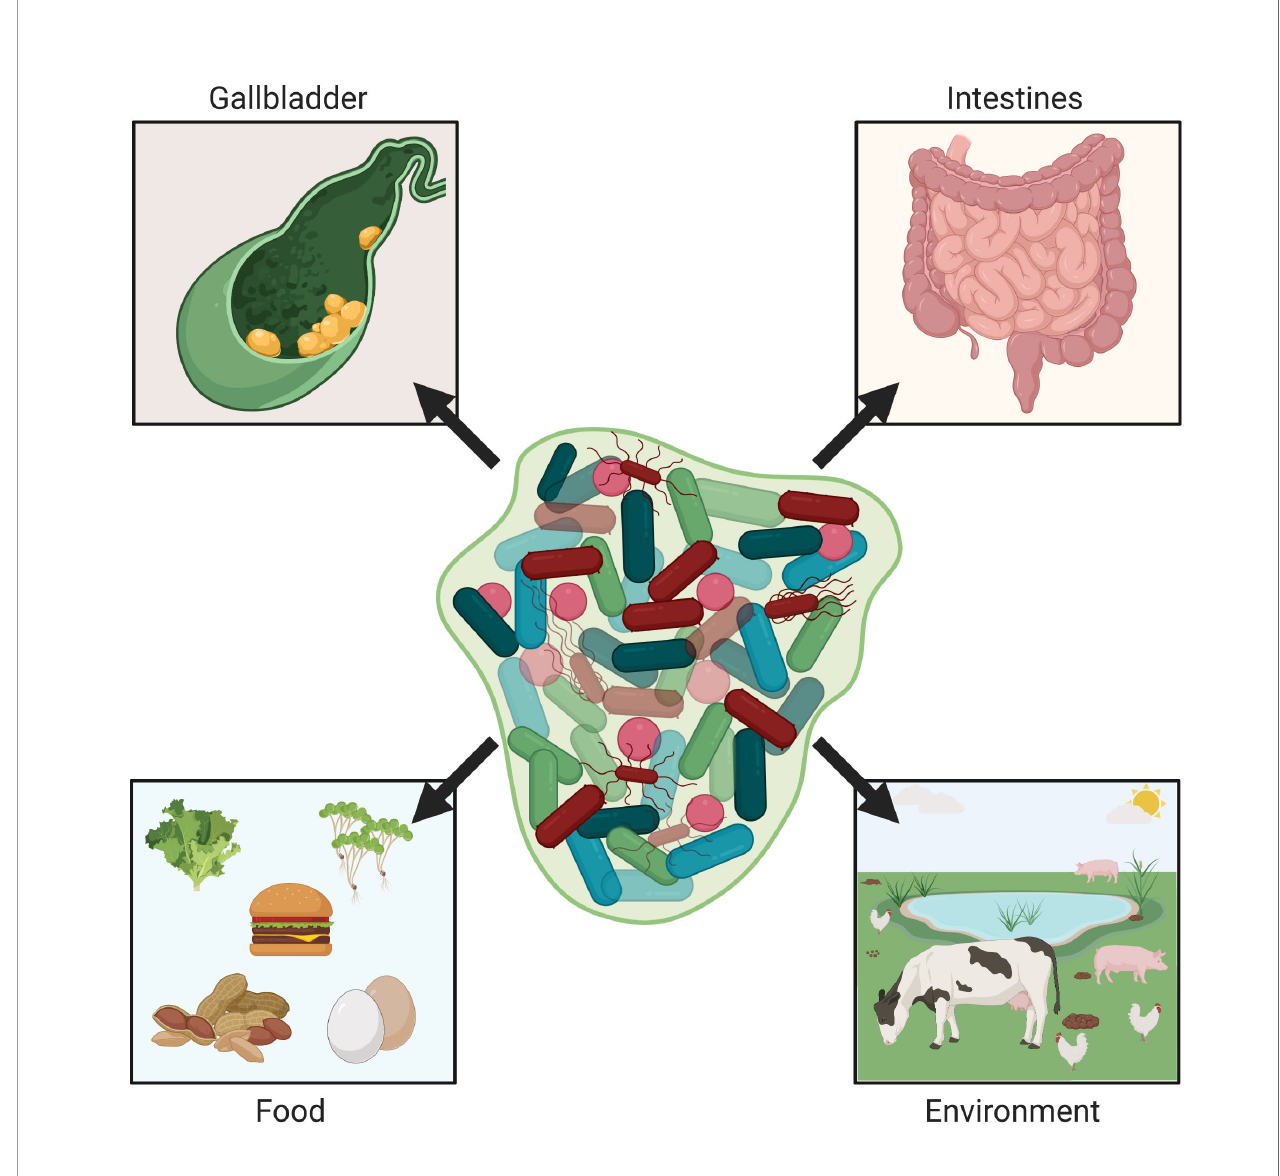
FIGURE 1 | Salmonella bio fi lms in the environment and humans. Non-typhoidal and typhoidal salmonellae are naturally acquired by humans through environmental or food sources. Salmonella Typhimurium colonizes and can form bio fi lms on various types of produce, while S . Enteritidis is often found within and on eggs. When within the intestines of various non-human animal species, salmonellae can cause either diarrheal disease or be a non-pathogenic inhabitant (e.g., in the chicken). This can lead to contaminated meat upon animal processing or shedding resulting in contaminated animal feces. Once ingested by the host, Salmonella spp. are capable of forming bio fi lms in the intestines and for S . Typhi, after systemically gaining access to the liver, can pass into the gallbladder and form bio fi lms on cholesterol gallstones. These bio fi lms within humans facilitate chronic Salmonella infection as well as continual shedding of Salmonella from the host. Images created with